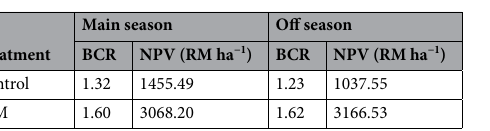
Table 10. Effect of different planting seasons on benefit–cost ratio (BCR) and Net Present Value (NPV).